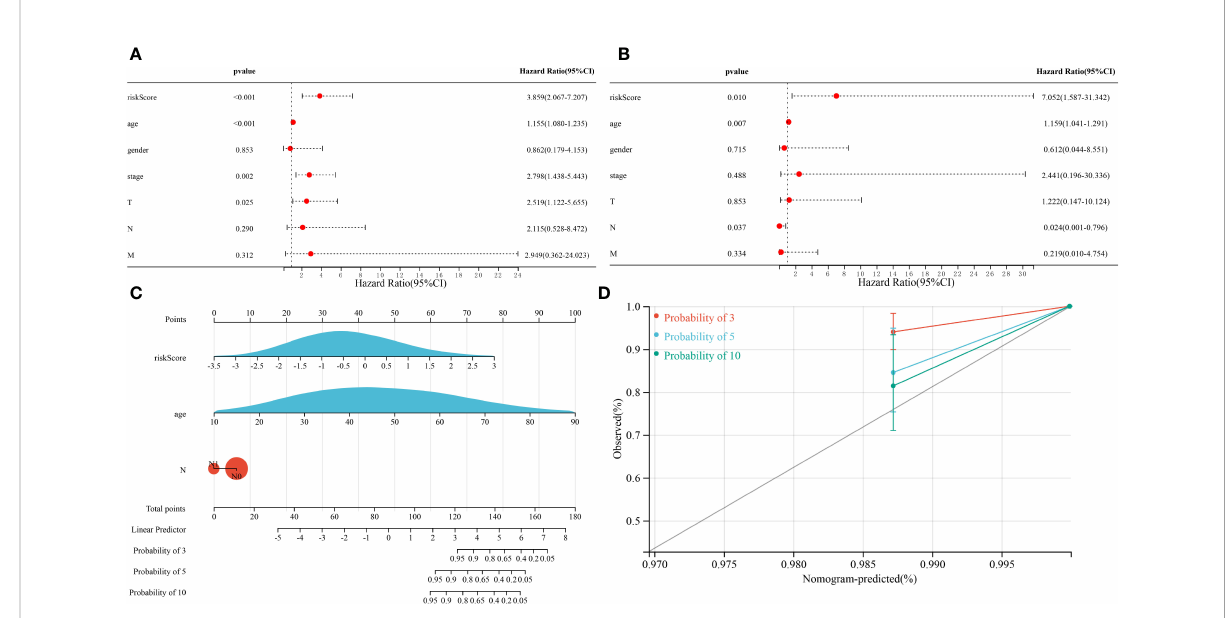
FIGURE 5 Results of the Cox regression analyses regarding OS in the TCGA cohort. (A) Univariate Cox regression analyses regarding OS in the TCGA cohort. (B) Multivariate Cox analyses regarding OS in the TCGA cohort. (C) A nomogram constructed from prognostic risk scores and clinicopathological factors. (D) Calibration curve for the